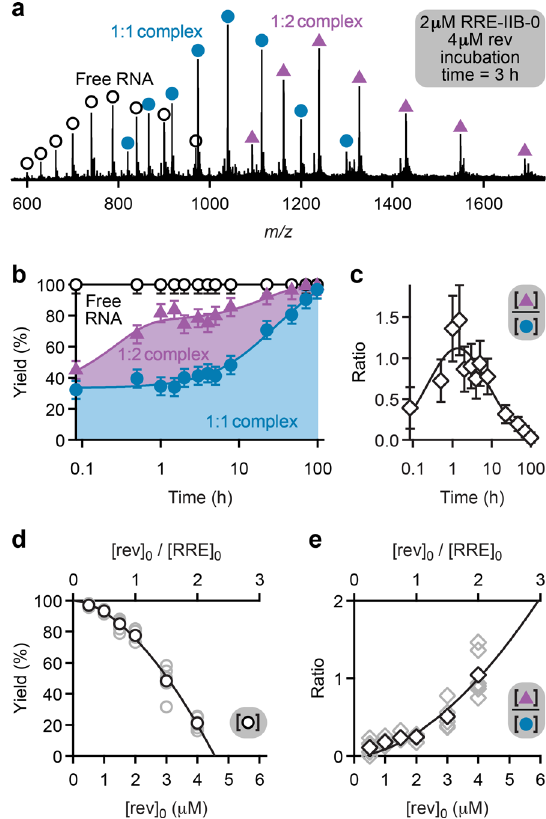
Fig. 2 RRE-IIB-0/rev complex stoichiometry probed by native MS. a ESI spectrum of a 2 µ M RRE-IIB-0 RNA and 4 µ M rev peptide solution in 9:1 H 2 O/CH 3 OH (pH ~7.5, adjusted by addition of ~1.25mM piperidine; 3 h incubation time) shows signals of free RNA (open circles), 1:1 complex ( fi lled circles), and 1:2 complex (triangles); b stacked area plot illustrating the yield of free RNA (open circles), 1:1 complex ( fi lled circles), and 1:2 complex (triangles), error bars show estimates obtained as described in the Methods section; c Ratio of 1:2 to 1:1 complex yields (diamonds) versus incubation time with error bars as described in the Methods section; d yield of free RNA at t = 1 – 5 h (gray circles, average values shown as black circles) and e ratio of 1:2 to 1:1 complex yields at t = 1 – 5 h (gray diamonds, average values shown as black diamonds) versus rev peptide concentration, [rev] 0 ( RRE-IIB-0 concentration, [RRE] 0 , was 2 µ M in all experiments). Source data are provided as a Source Data fi